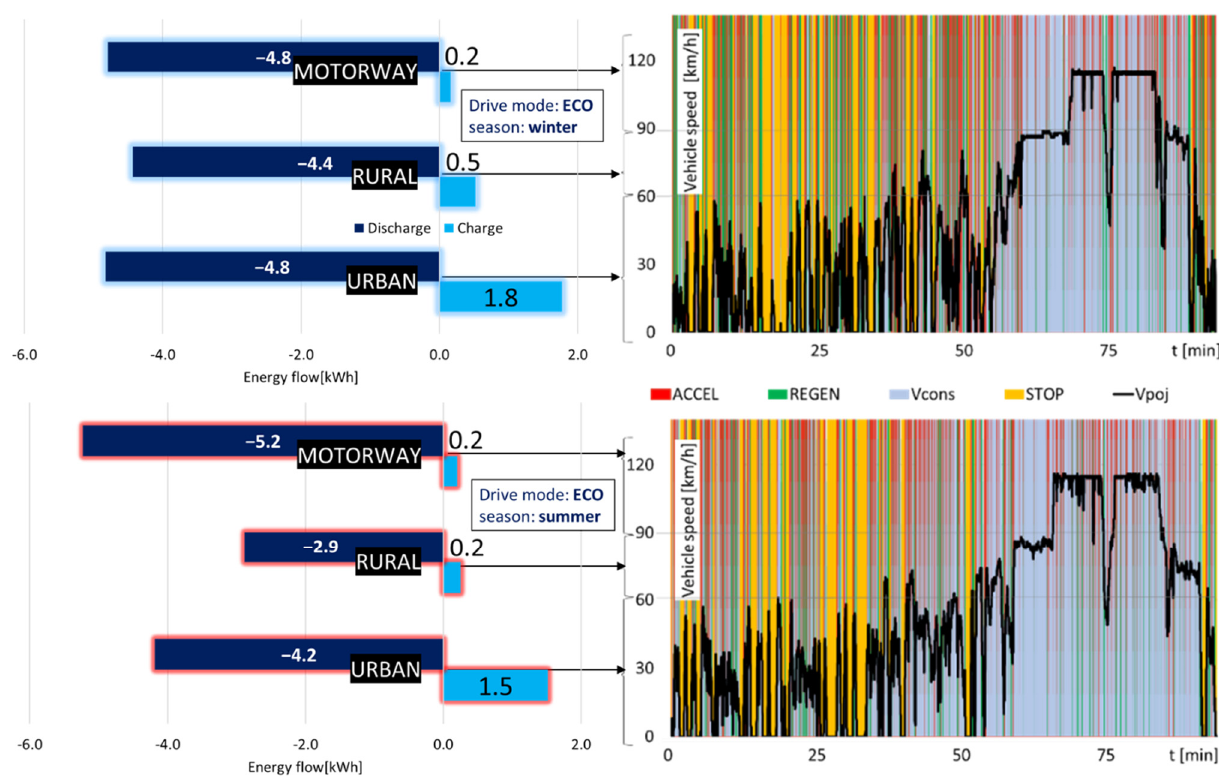
Figure 21. Energy flow for specific route conditions under RDC test conditions.